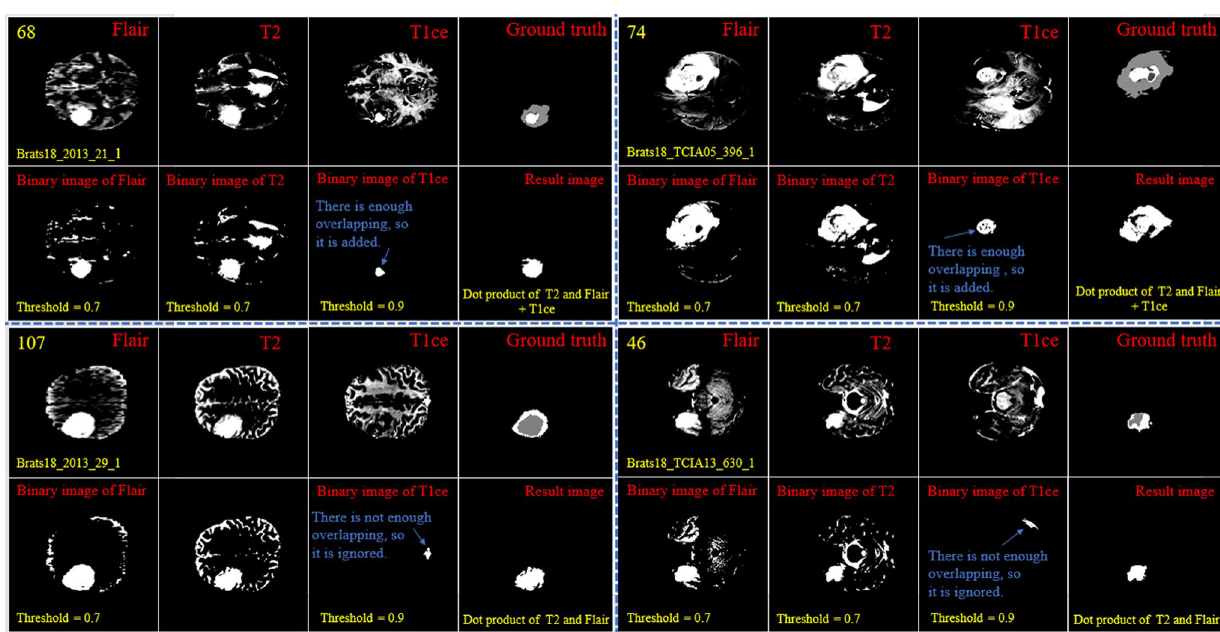
Figure 4. Demonstration of the process of finding a part of the tumor in each slice. The yellow color in the top left corner and the bottom indicates the slice number and sample ID, respectively. Also, the conditions for selecting the object are shown in yellow color. The red color is chosen for identifying the presented image. All binary objects inside the binarized T1ce image are bigger than the threshold criteria, so they were eliminated.